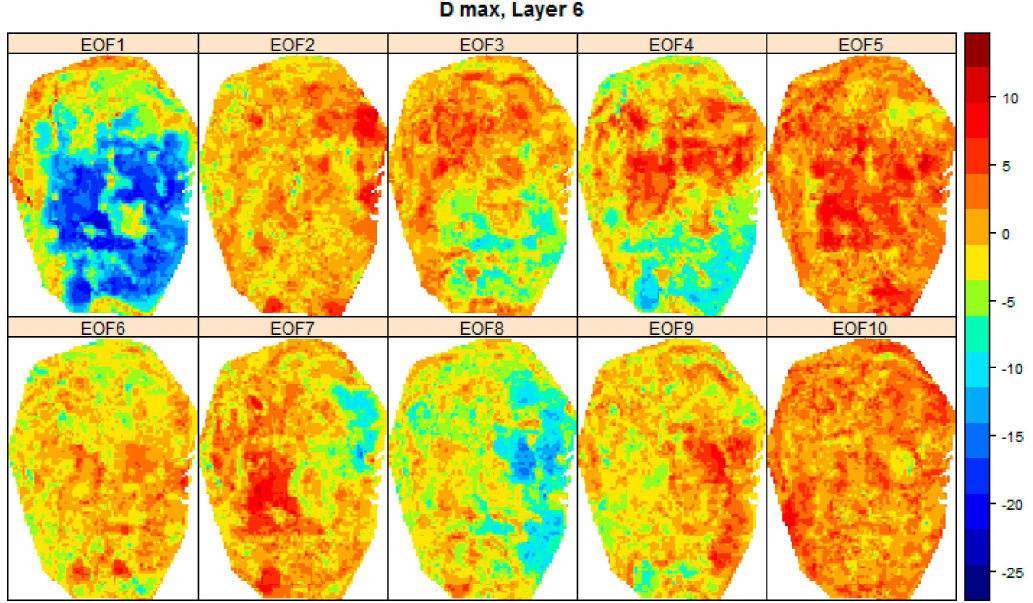
Figure 7. Spatial basis function for D-max in model layer 6. The subplots show the dominant 10 empirical orthogonal functions (EOF) that explain the greatest proportion of variability in the ensemble flow model runs.